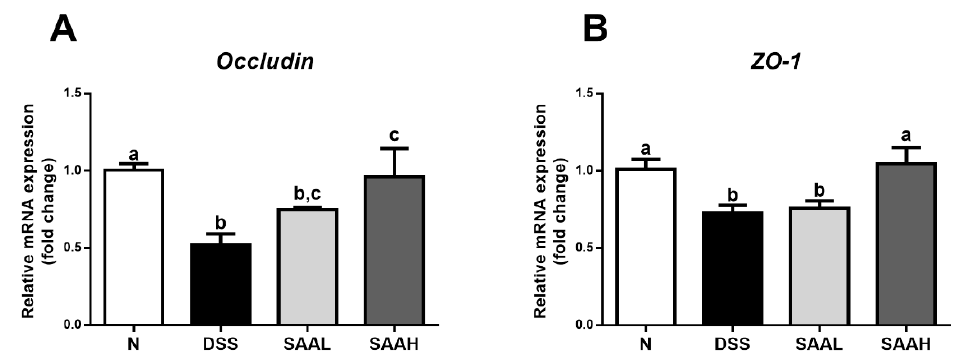
Figure 4. Effects of salvianolic acid A on the expression of genes coding for colonic tight junction proteins in DSS-induced-colitis rats. ( A ) The rats’ distal colons were collected, and mRNA expression of genes coding for the tight-junction proteins occludin ( A ) and ZO-1 ( B ) was quantified using real-time PCR. Fold changes are expressed as means ± SEM ( n = 8 for each group in a single experiment). Groups with different letters differ by a statistically significant margin ( p < 0.05).